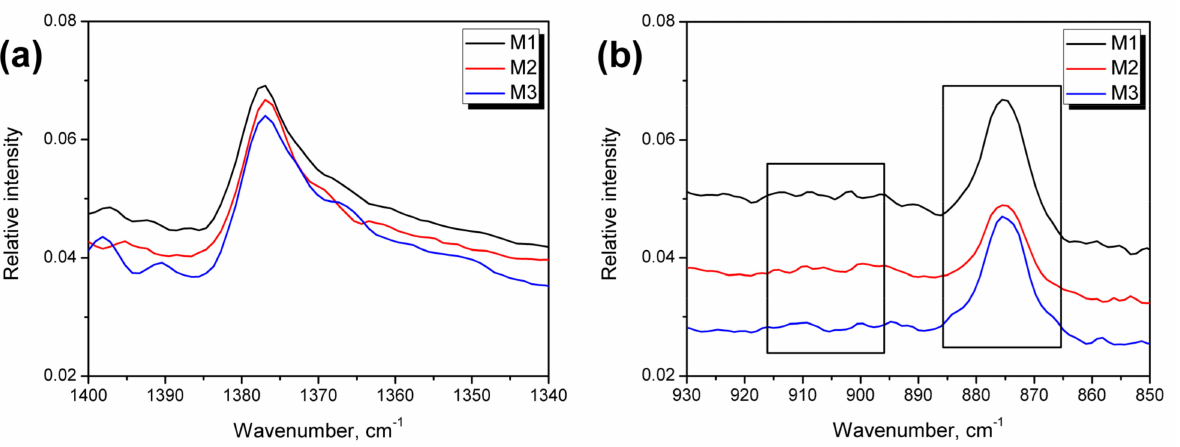
Figure 5. Detailed Fourier-transform infrared spectra of analyzed wastes in the range ( a ) 1340–1400 cm − 1 and ( b ) 850–930 cm − 1